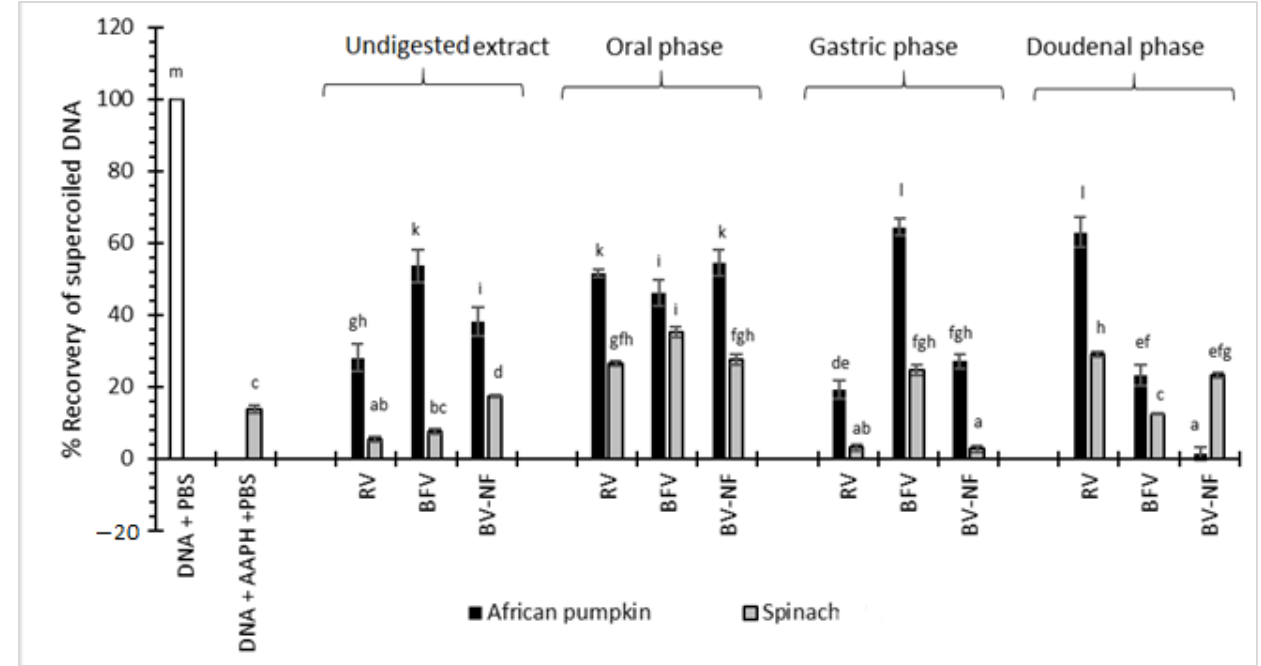
Figure 4. % Recovery of supercoiled DNA. DNA + PBS—DNA mixed with 0.1 M phosphate-buffered solution (PBS), DNA + AAPH—DNA mixed with 1 mg/mL AAPH. Raw vegetable (RV), boiled filtered vegetable (BFV), boiled vegetable—not filtered (BV-NF). Alphabets in superscripts on bars show significant differences at p < 0.05.